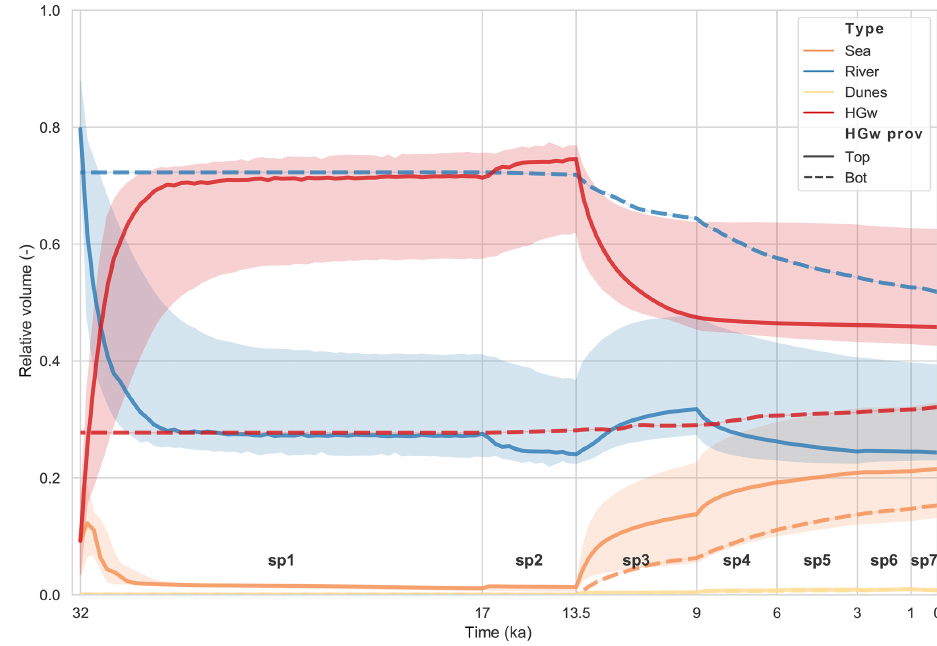
Figure 5. Groundwater provenance of different water types as a fraction of the total modelling domain for the five acceptable model scenarios. The dashed lines represent the C-M-B-P model. The shaded area indicates the range of the acceptable T-model scenarios (C-N-T-P, H-N-T-P, H-F-T-P, H-M-T-P), the thick line their median. Stress period numbers are indicated in bold, preceded by “sp”.